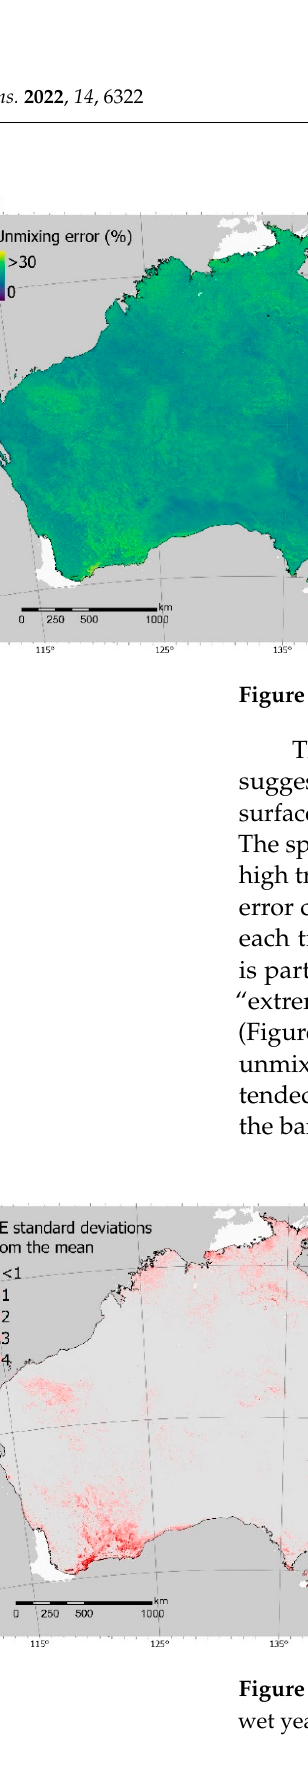
Figure 9. Box plots showing year 2016 ( top ) and year 2019 ( bottom ) median unmixing error distri- bution for 16 vegetation structural classes in Australian drylands. n > 50,000 for every structural class (Structural classes definitions in Figure 8). Although the unmixing error depicts the model’s uncertainty, it was found not to be strongly linked to accuracy errors detected through field validation. A significant ( p <